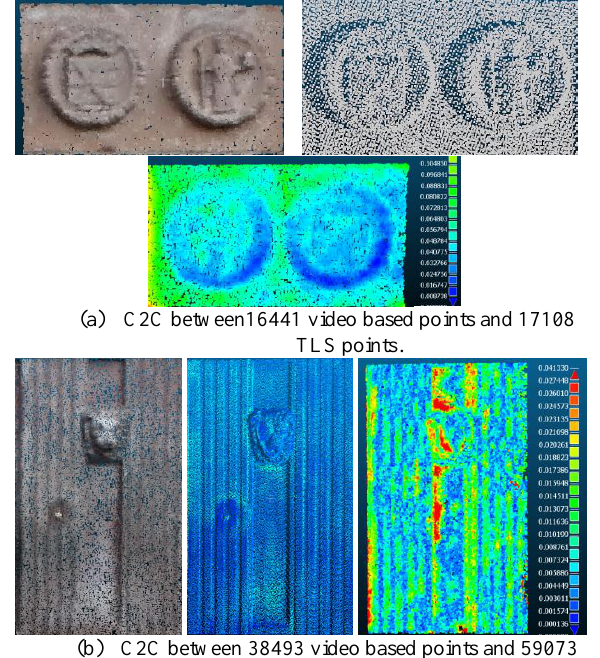
Figure 22. Validation of the video imaging for the monument. (a) C2C comparison of 1 st patch. (b) C2C comparison of 2 nd patch.